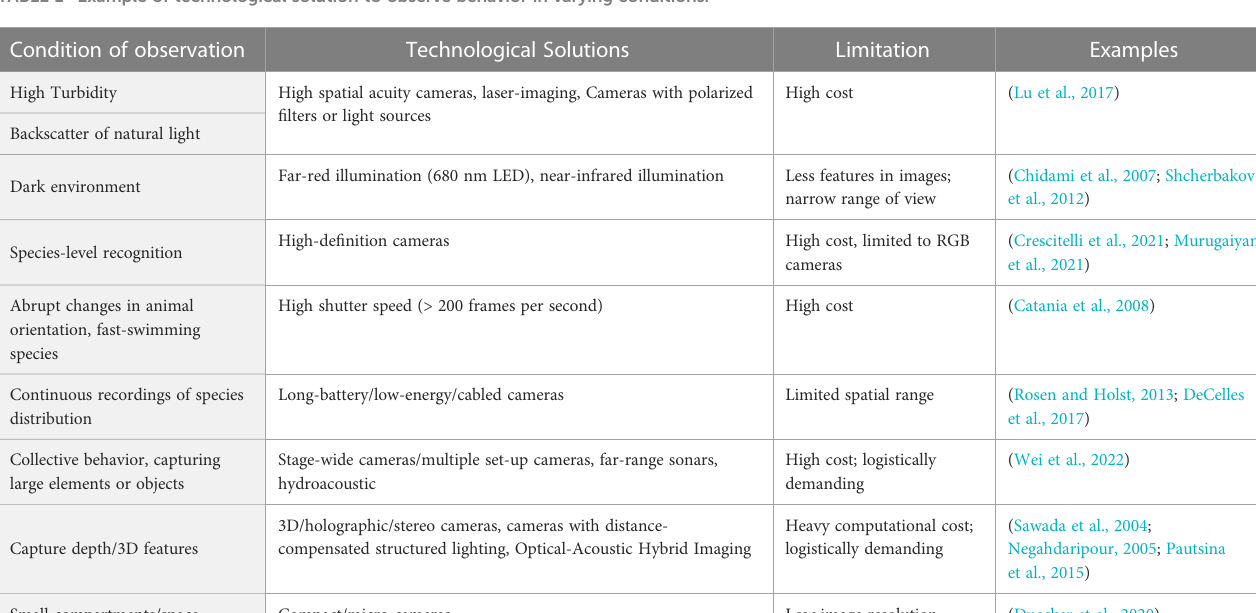
TABLE 1 Example of technological solution to observe behavior in varying